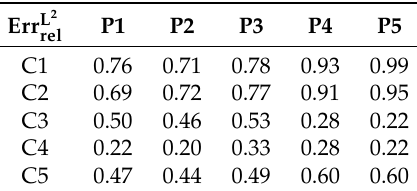
Table 3. L 2 error norms of the pressures shown in Figure 5 relative to those obtained in the experiment. C1–C5 are the simulation cases introduced in Table 1.